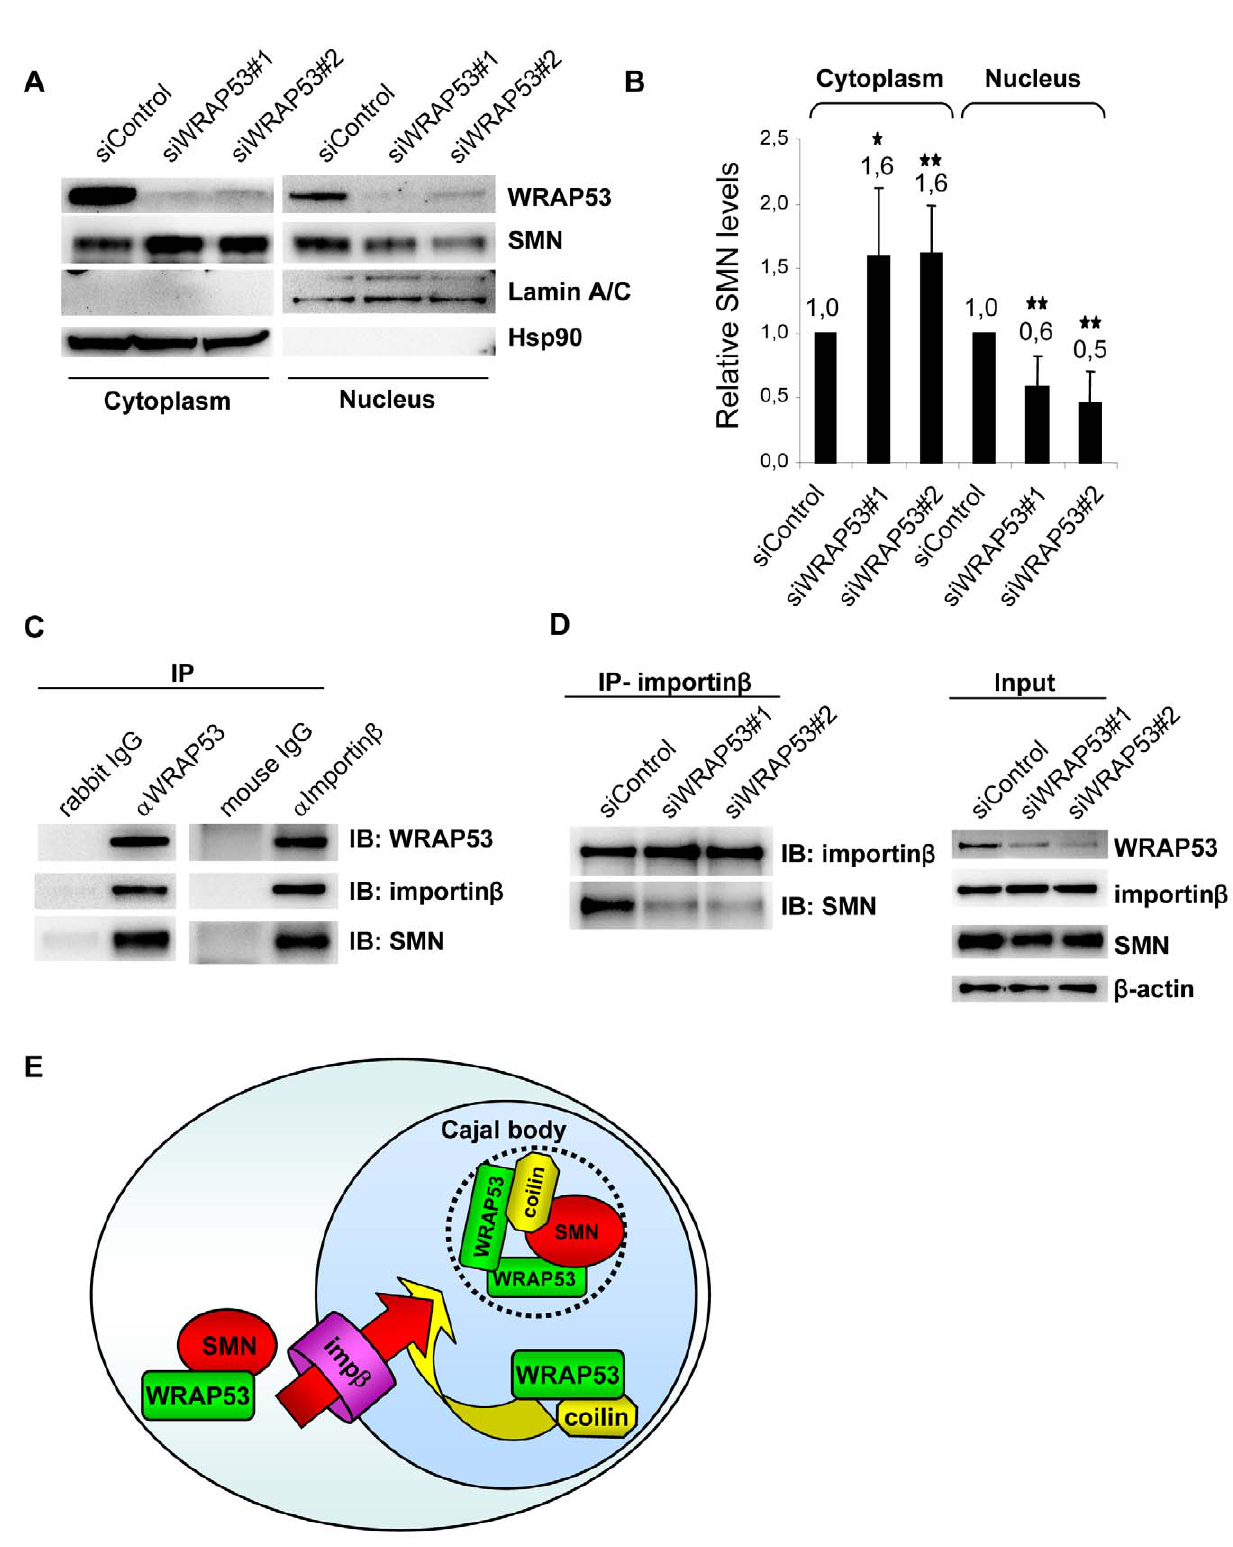
Figure 6. WRAP53 regulates SMN distribution and mediates SMN–importin b interaction. (A) WB analysis of SMN levels in fractionated U2OS cells treated with the indicated siRNA oligos. (B) Densitometric quantifications of SMN levels in fractionated U2OS cells treated with the siRNAs shown in (A). Levels of SMN have been normalized against the internal fractionation control. The graph shows means of five independent experiments; error bars represent standard error; one asterisk indicates p , 0.05, two asterisks indicate p , 0.01, according to the Student’s t test. (C) IP of endogenous WRAP53 and importin b from U2OS cells. Rabbit and mouse IgG were used as negative controls. (D) IP of endogenous importin b from